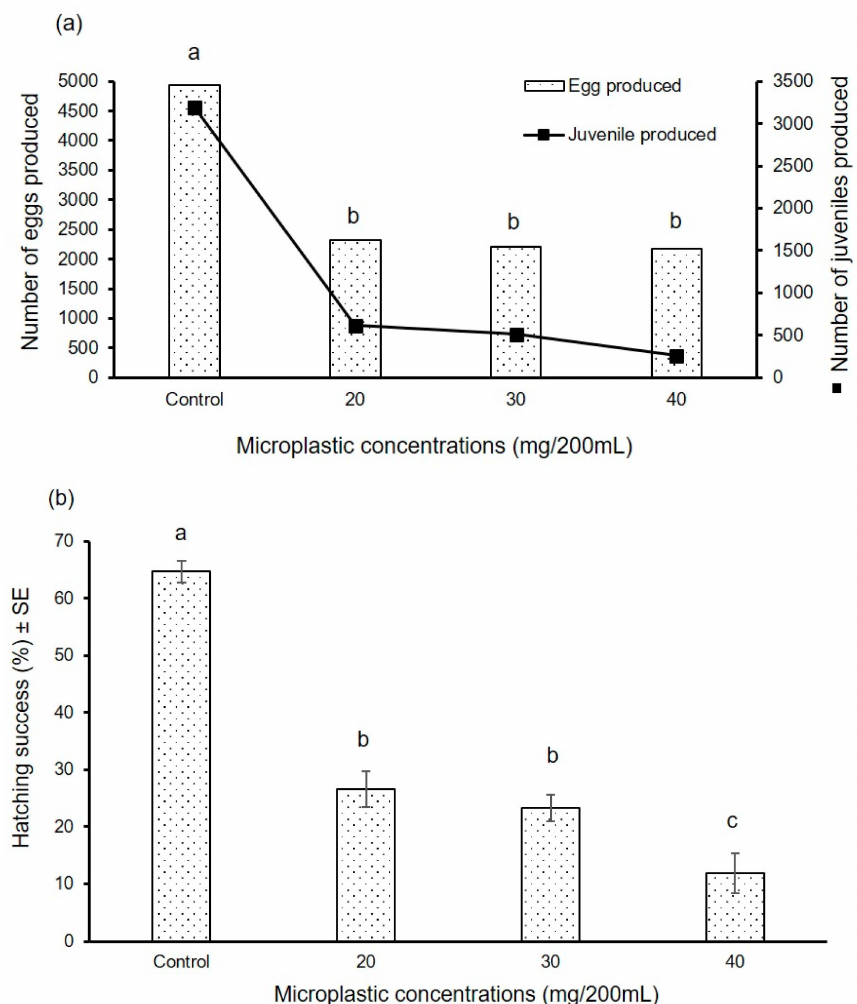
Figure 8. Reproductive output of P. acuta ( n = 10) in terms of ( a ) total number of eggs produced and juveniles hatched for 93 days after maturity and ( b ) egg hatching success ( ± SE) in control and in the medium applied with three concentrations (20, 30 and 40 mg/200 mL) of microplastics. Data points with differences superscribed with different letters are statistically significant ( p <